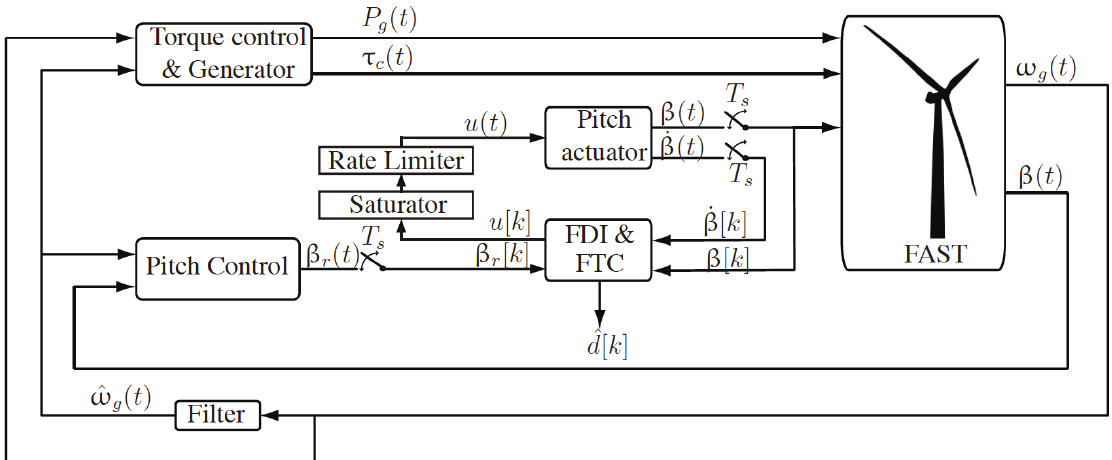
Figure 2. Block diagram of the closed loop system. Note that the torque control and the pitch control already include their respective saturator and rate limiter blocks.